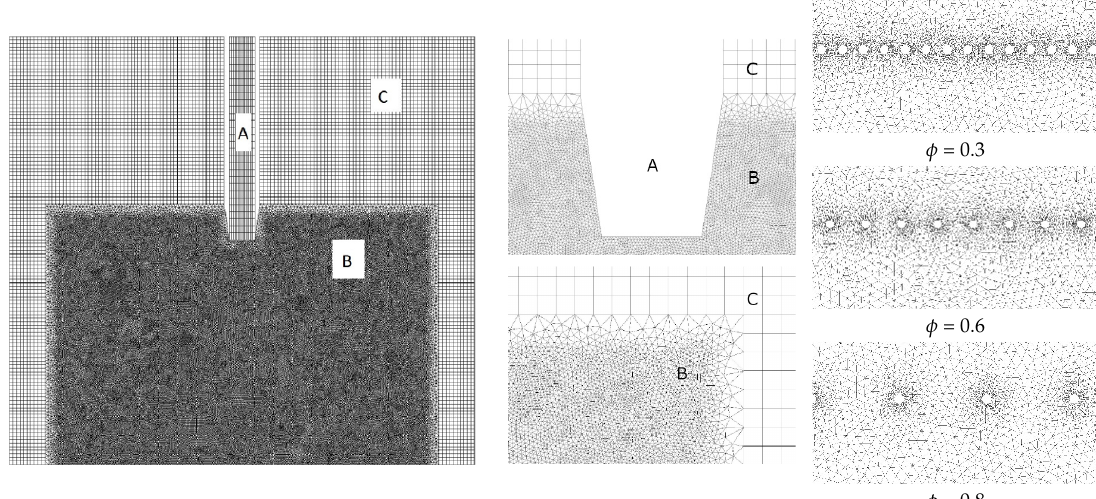
Figure 2. Full view for mesh of geometry and partial view near piston and flow area.